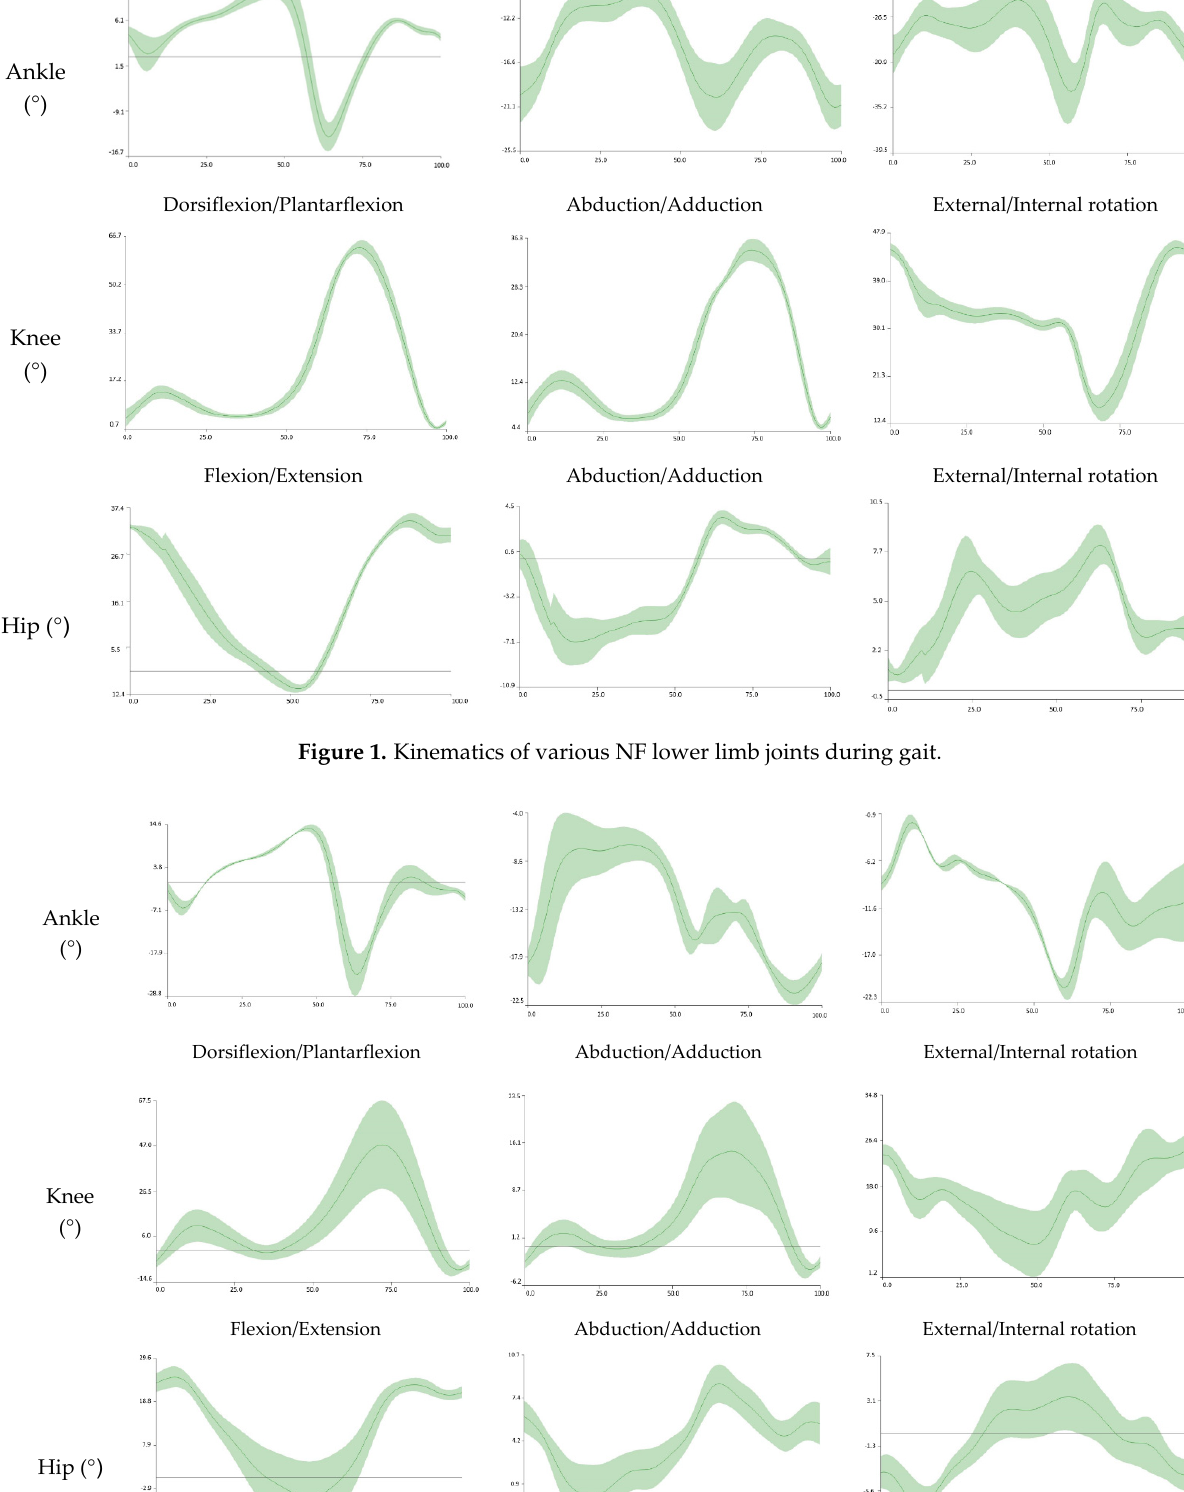
Figure 3. Center of mass variation of NF subjects alongside gait pattern. Figure 4. Center of mass variation of FF subjects alongside gait pattern. 4. Discussion FF is a condition that can be triggered by several reasons, namely, neurological or muscular restrictions, ligament laxity, joint laxity, excessive motion, and muscle activity [13,33–35]. It is present in children, targets 10–25% of adults, and can be disastrous for patients as the foot problems prevalence has been reported to be from 46% to 80% in both clinical and institutional situations. This leads to several injuries, often accompanied by